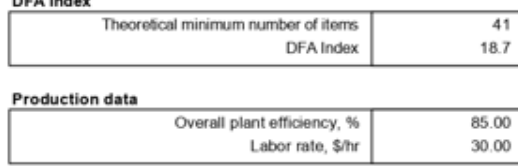
Figure 10. Minimum factor of safety and maximum stress of the redesigned stove.